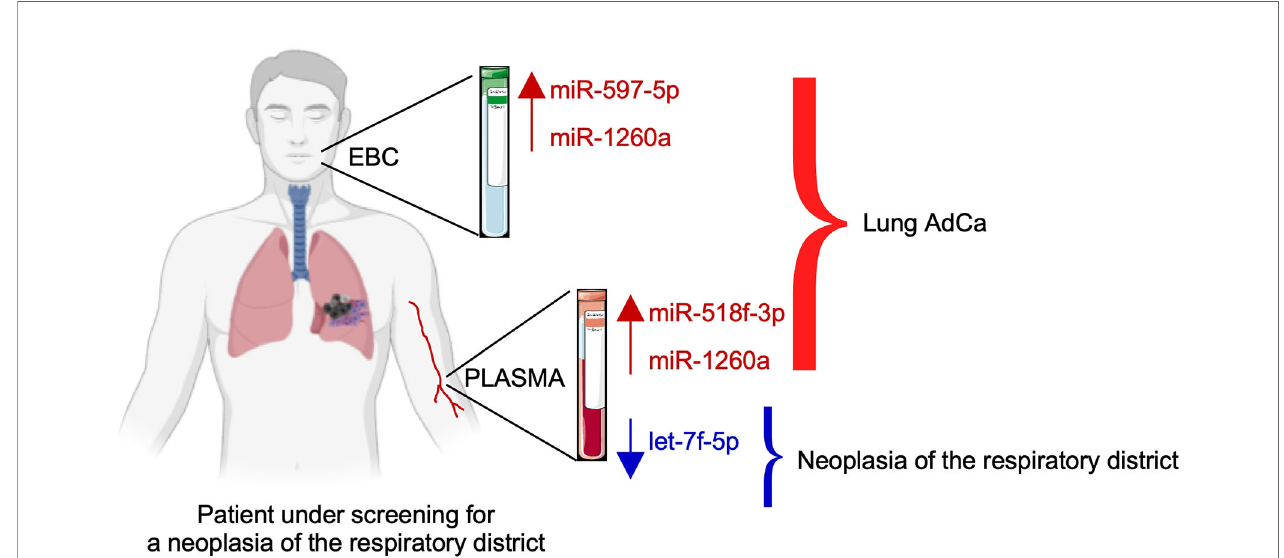
FIGURE 5 | Schematic of the proposed model of the three-miRNAs signature as an adjunct tool to screen subjects for lung cancer